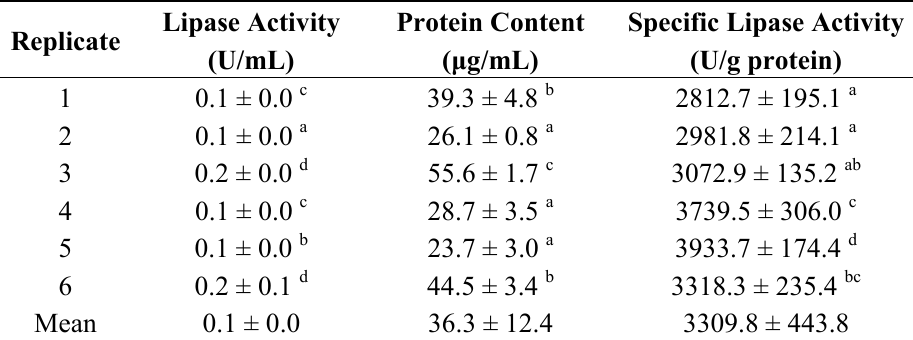
Table 3. Properties of free or extracellular